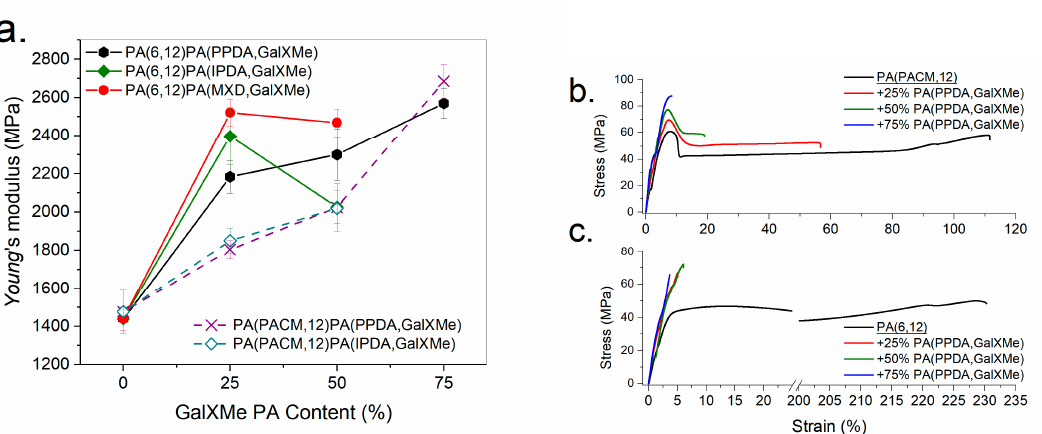
Figure 8. Results of the tensile tests for PA(6,12) and PA(PACM,12) blended with ( a ) PA(PPDA,GalXMe), PA(IPDA,GalXMe), and PA(MXD,GalXMe) expressed as E modulus as a function of the amount of GalXMe polyamide and stress–strain curves for ( b ) PA(PACM,12) blended with PA(PPDA,GalXMe) and ( c ) PA(6,12) blended with PA(PPDA,GalXMe).